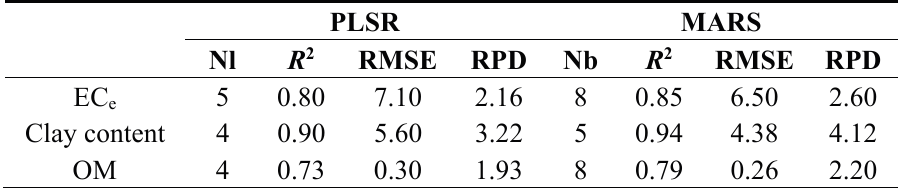
Table 3. Cross-validation results of PLSR and MARS models for the estimation of soil properties based on ASTER spectra.